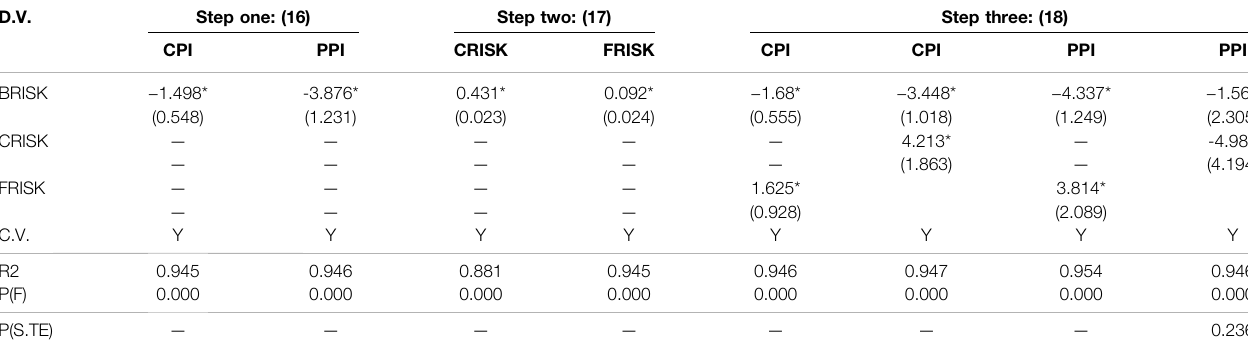
TABLE 4 | Test on the mediating effect of commodity market risk and fi nancial market risk when oil commodity attribute